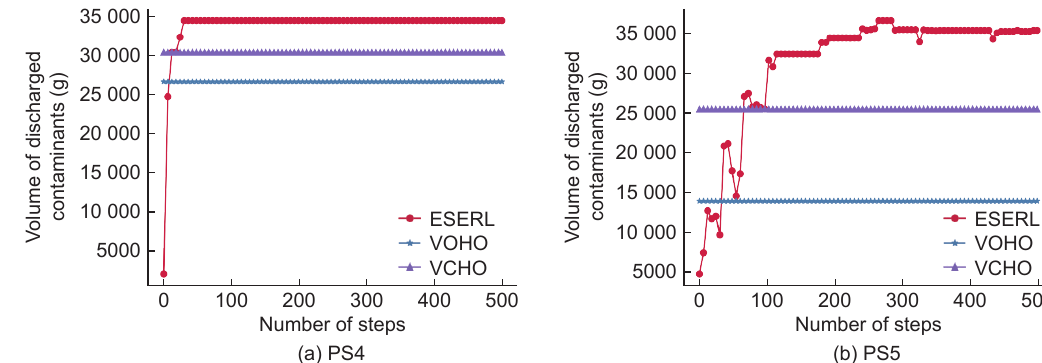
Fig. 8 Volume of discharged contaminants for multiple pollution events by ESERL, VOHO, and VCHO.